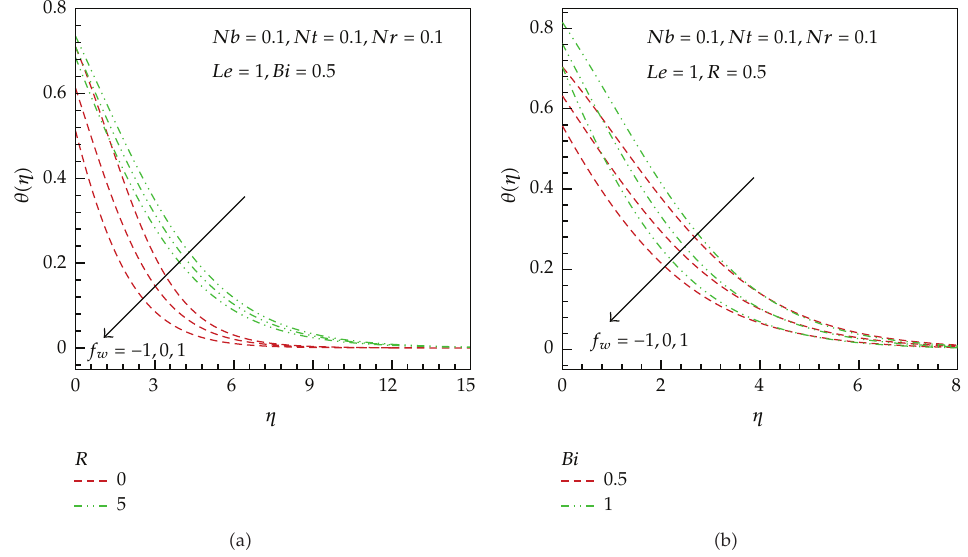
Figure 4: E ff ect of (cid:3) a (cid:4) radiation parameter, (cid:3) b (cid:4) Biot number on the dimensionless temperature for di ff erent values of suction/injection